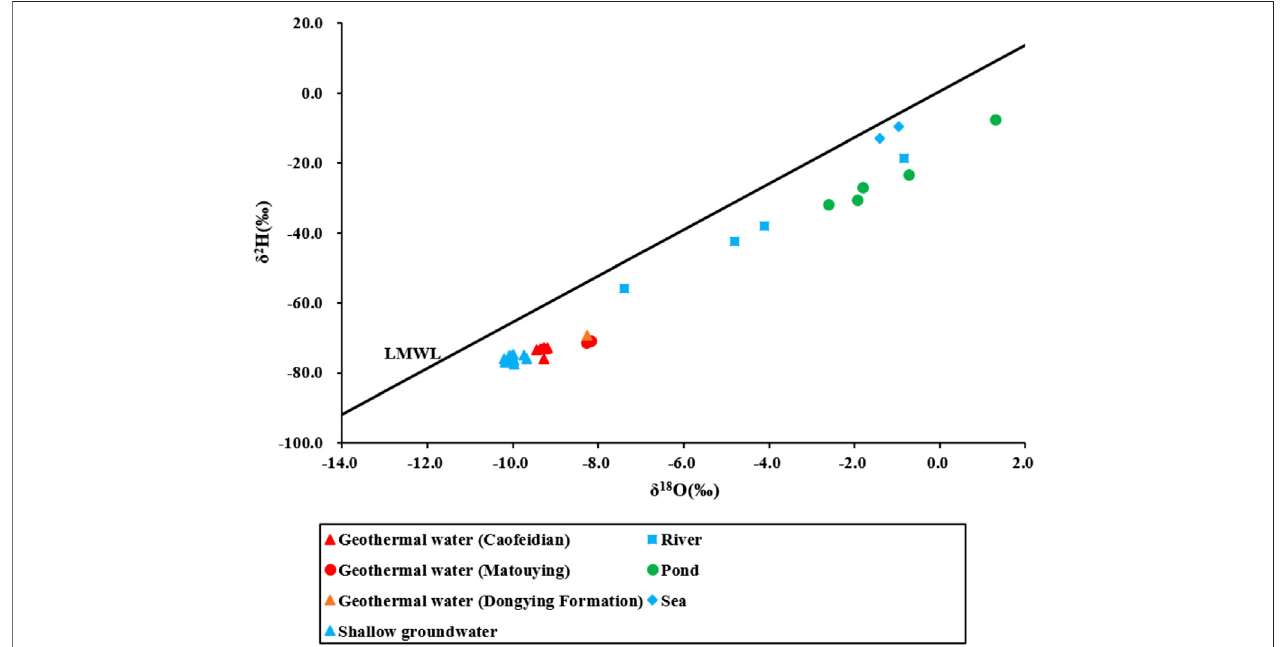
FIGURE 7 | Isotopes of all the water samples at the Caofeidian and the Matouying.